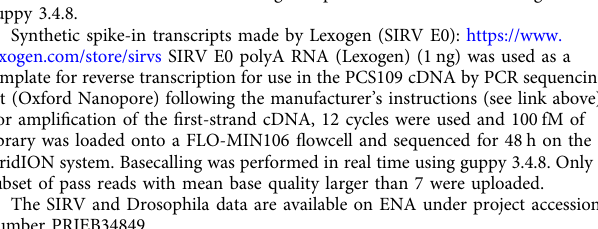
Fig. 5 Overview of isONcorrect. The input to isONcorrect is reads from a single cluster produced by isONclust (or any other software that group reads into gene families of origin). This fi gure illustrates a cluster with fi ve reads ( r 1 – r 5) from three isoforms. isONcorrect fi nds all intervals with distance between x x min to max using anchor minimizers (shown as colored blocks) and adds them to a hash table. To correct a single read (e.g. pairs found in r 1 are queried in the hash table, and all reads containing a given anchor minimizer pair are retrieved. In this example, r 1 has 11 such anchor pairs (shown in Step 1). Each anchor pair is assigned a weight that is the product of its span and the number of reads containing this anchor pair (with the exception of fi ltering out anchor pairs of dissimilar regions; details in “ Methods ” ; Step 1). For example, the anchor pair ( p 1, p 2) occurs in three reads ( r 1, r 2, and r 3). The instance is sent to a weighted interval scheduler that fi nds the set of non-overlapping anchor pairs with the largest weight (Step 2). In this case, four anchor pairs are selected. All segments between the chosen anchor pairs are sent for correction. A consensus is created (Step 3) using spoa, and one or more trusted variants are identi fi ed, based on their frequencies and sequence contexts (Step 4). Each read segment in r 1 is corrected to the closest trusted context (Step 5). The segments are inserted back into the original read r 1 in what becomes the corrected read of r 1 (Step 6). An optional Step 7 corrects the segments of the other reads in the same manner and stores them in a hash table to be retrieved whenever it is their turn to be corrected. For example, when it is r 2 ’ s and r 3 ’ s turn to be corrected, the interval spanned by the anchor pair ( p 1, p 2) may be again encountered in the optimal scheduling solution, allowing Steps 3 – 5 to be skipped at that